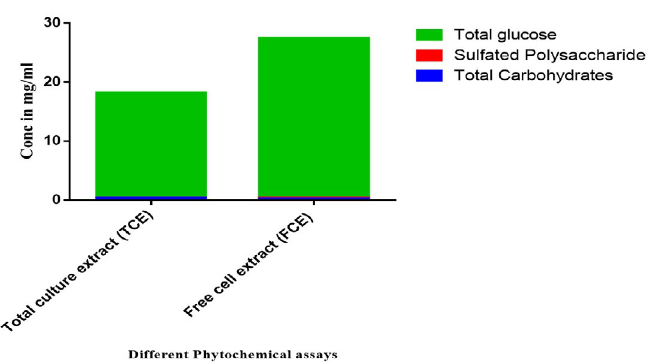
Fig. 3. The phytochemical analysis of total culture extract (TCE) and free cell extract (FCE) for total carbohydrates, sulfated polysaccharides, and total glucose.